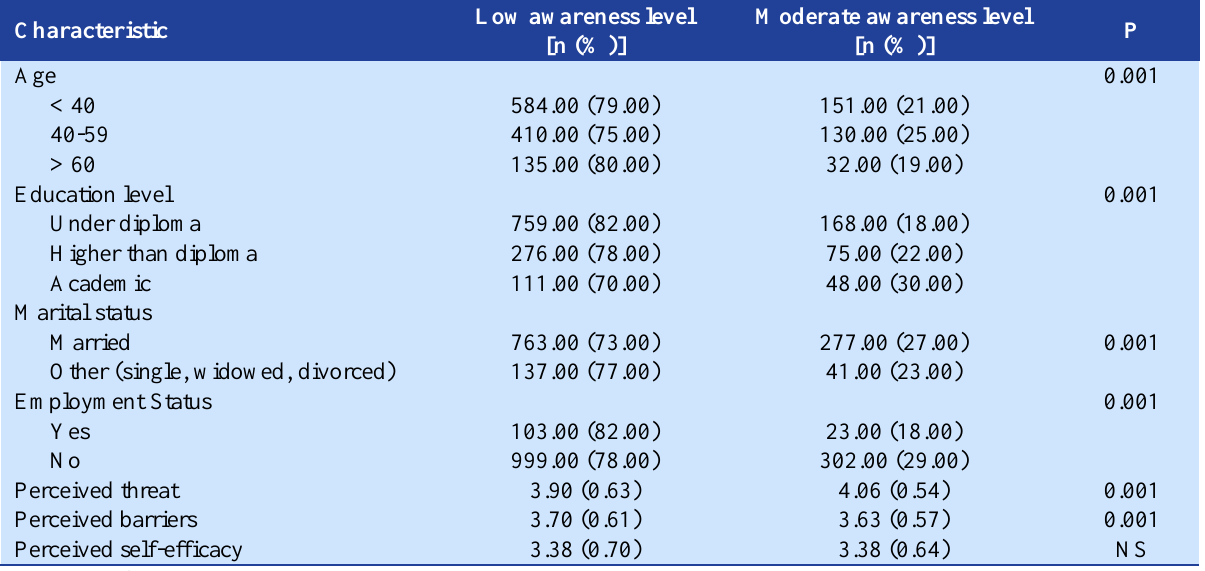
Table1. Awareness level and attitudes across socio-demographic characteristics